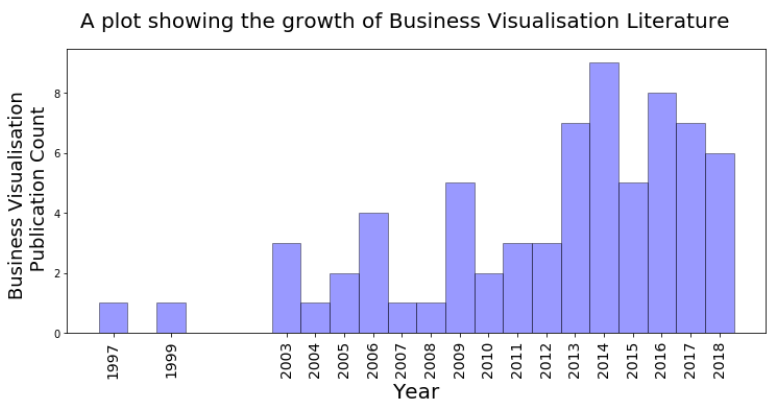
Figure 28. This figure shows the growth of the Business Visualisation literature included in this